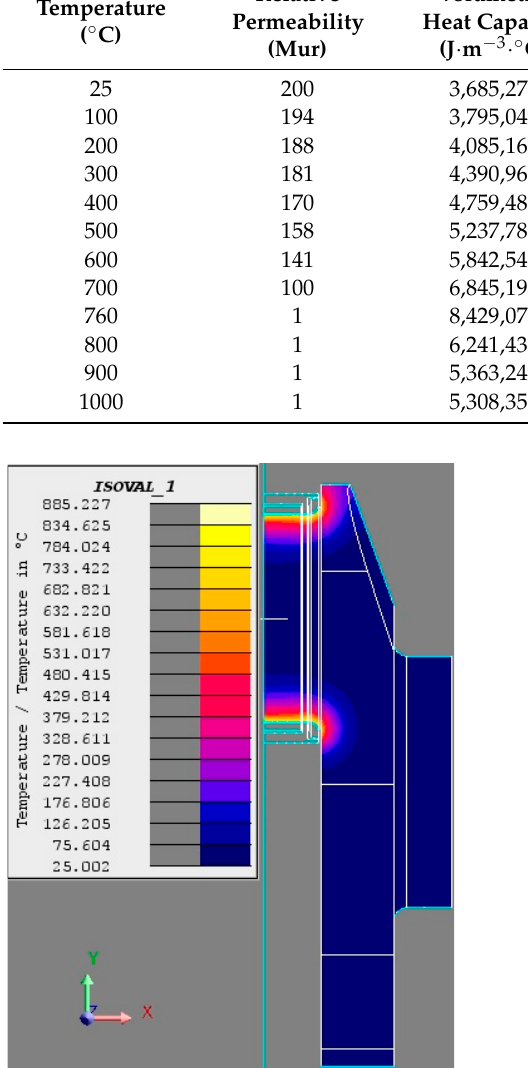
Figure 7. The evolution process of the temperature field during the heating stage (T = 3 s).